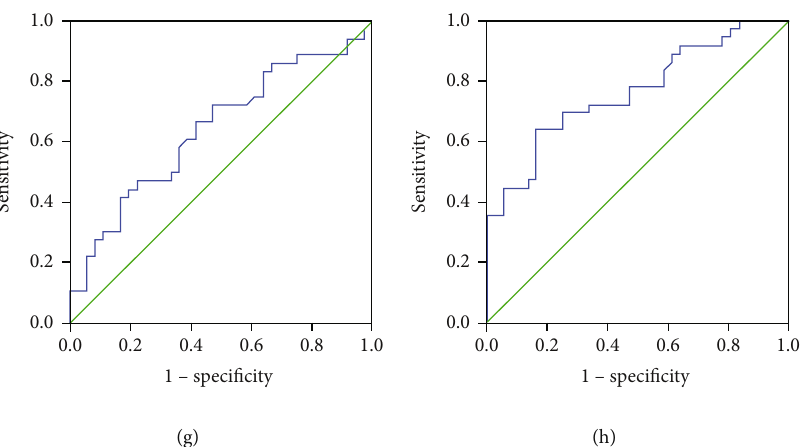
Figure 2: ROC curves of potential predictive cytokines for postoperative recurrence of CRSwNP. (a) eotaxin; (b) G-CSF; (c) IFN- α ; (d) IL- 13; (e) IL-17A; (f) IL-6; (g) MCP-1; (h) RANTES. ROC: receiver-operating characteristic; CRSwNP: chronic rhinosinusitis with nasal polyps; G-CSF: granulocyte colony-stimulating factor; IFN- α : interferon alpha; IL: interleukin; MCP: monocyte chemotactic protein; RANTES: regulated upon activation normally T expressed and presumably secreted. Table 3: ROC analysis results of di ff erent cytokines for predicting CRSwNP recurrence.